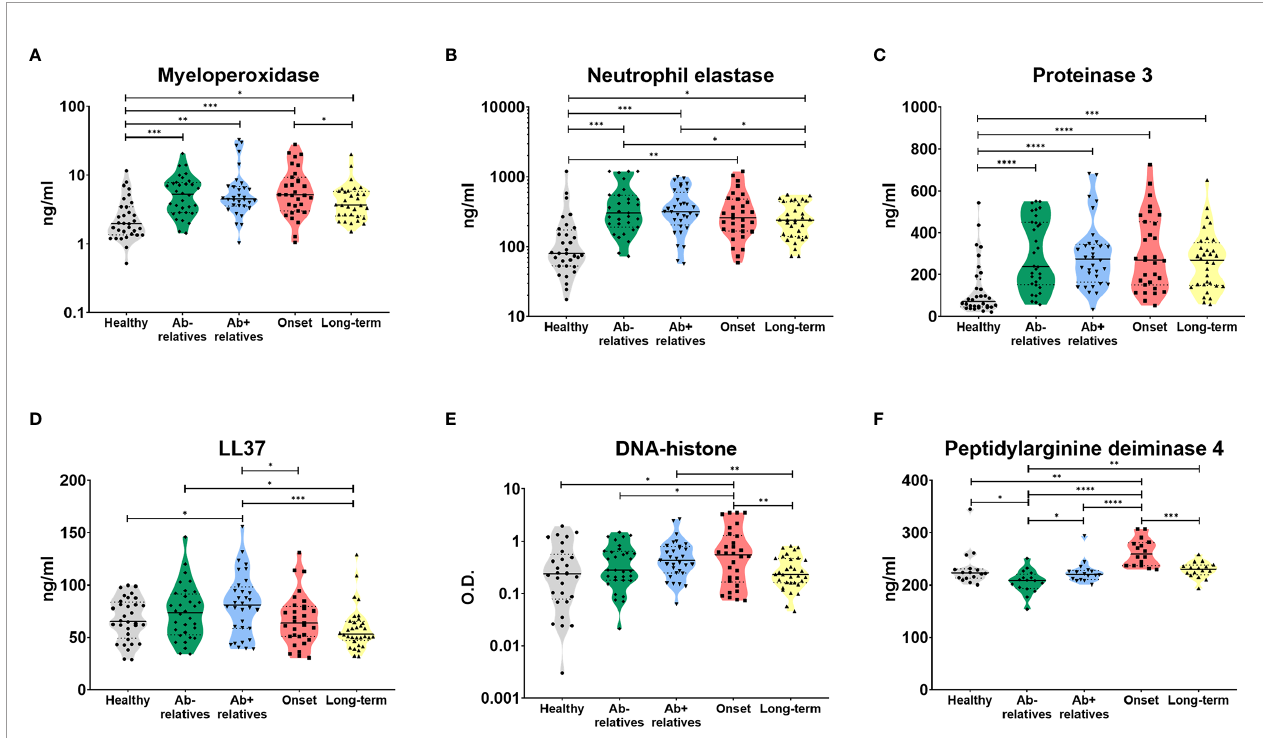
FIGURE 2 | Serum products of NETosis. Products of NETosis (A) myeloperoxidase, (B) neutrophil elastase, (C) proteinase 3, (D) LL37, (E) DNA-histone complexes and (F) peptidyl arginine deiminase 4) in the serum of healthy controls, antibody negative and antibody positive fi rst-degree relatives of T1D patients, T1D patients at the clinical onset of the disease and T1D patients with long-term, well-established disease. Unpaired t-test with Welch ’ s correction p-values shown, p=0.01-0.05 (*), p=0.001-0.01 (**), p<0.001 (***), p<0.0001 (****). O.D. = optical